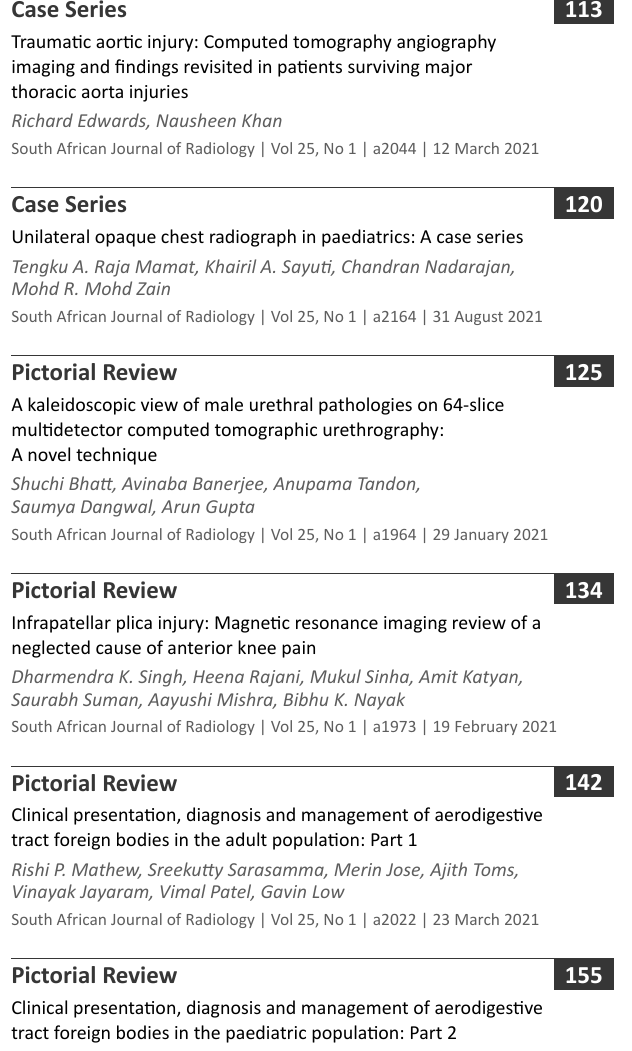
Clinical presentation, diagnosis and management of aerodigestive tract foreign bodies in the paediatric population: Part 2